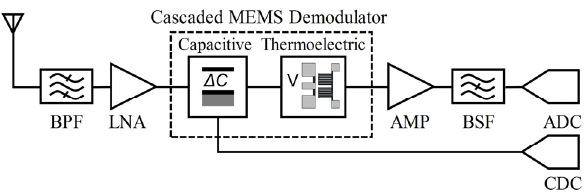
Figure 1. MEMS ‐ based demodulator is a part of a radio receiver.